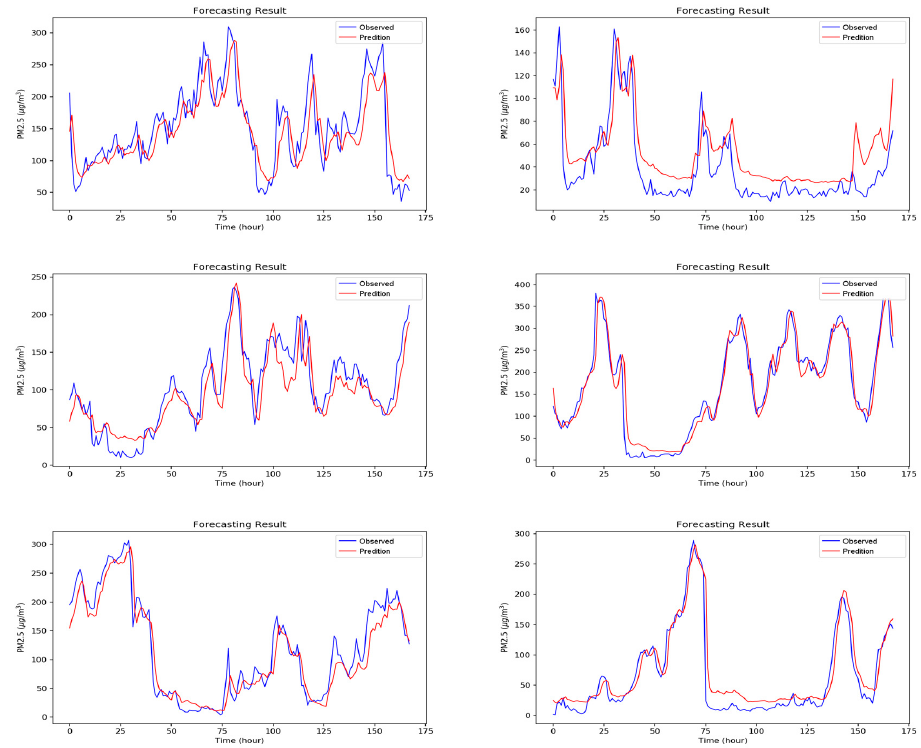
Figure A4. The forecasting results of Multilayer Perceptron (MLP).